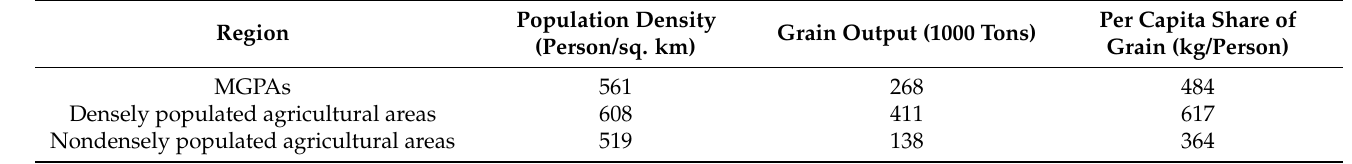
Table 1. Comparison of the mean values of relevant indicators in different regions in 2018. Population Density Per Capita Share of Region Grain Output (1000 Tons) (Person/sq. km) Grain (kg/Person) MGPAs 561 268 484 Densely populated agricultural areas 608 411 617 Nondensely populated agricultural areas